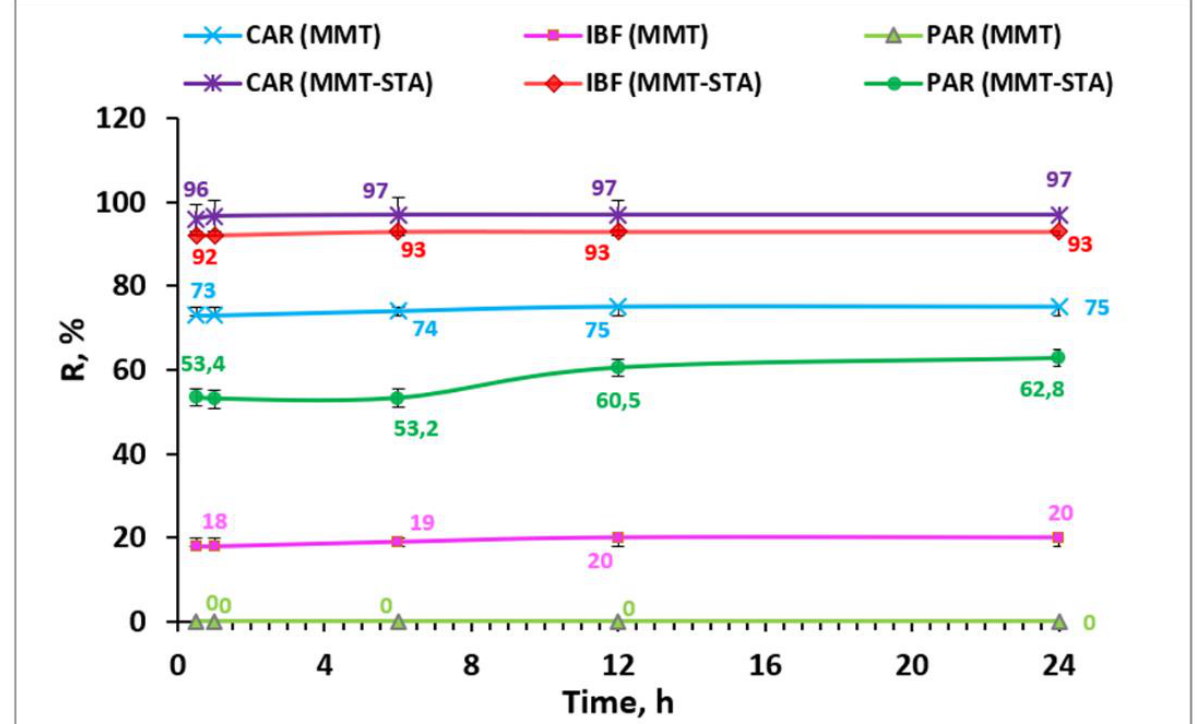
Figure 3. Effect of contact time on the removal efficiency of PP by pristine MMT and modified MMT – STA.